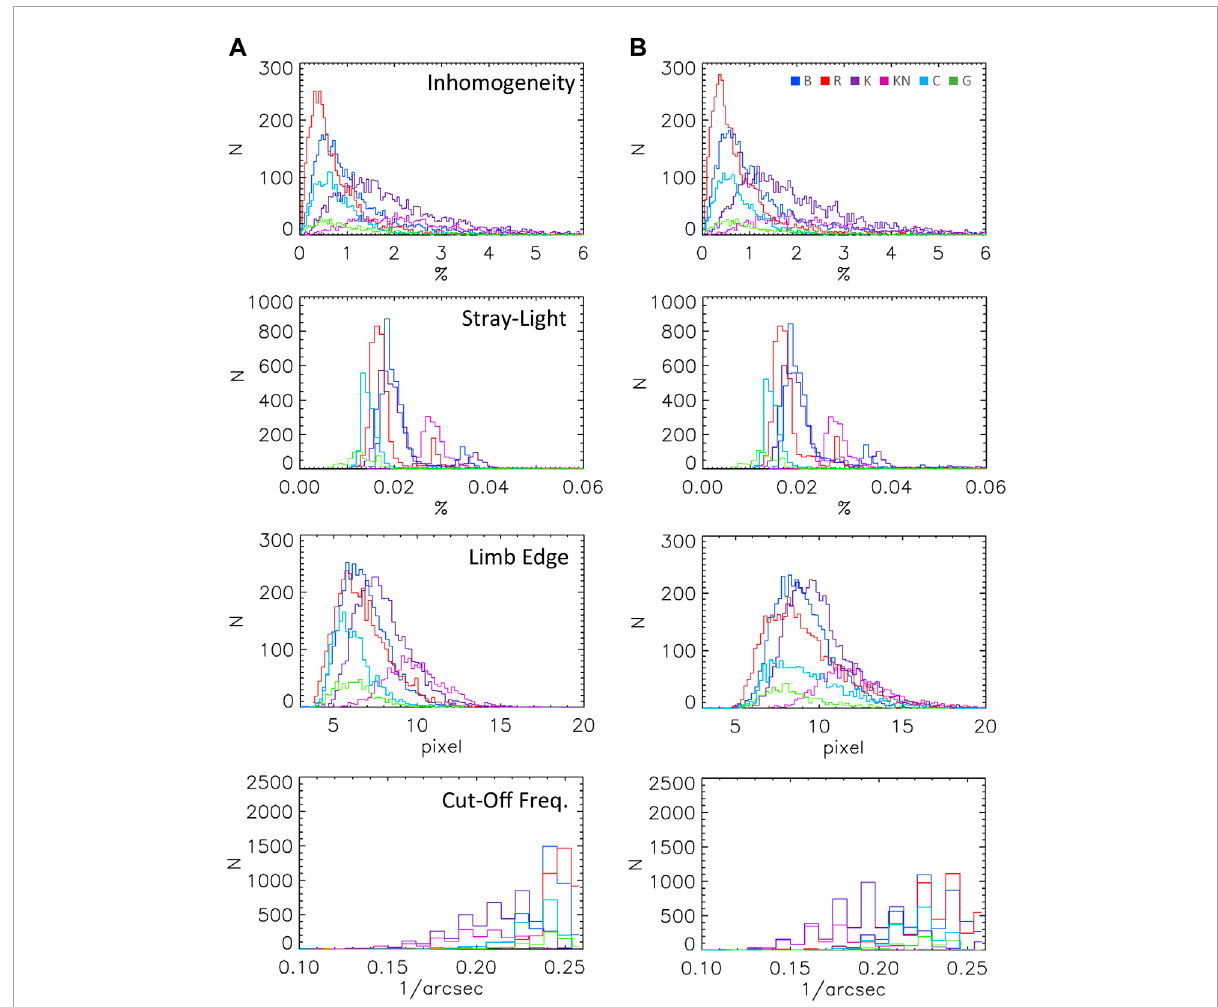
FIGURE 8 Distribution of the values of the parameters measured in each Rome/PSPT image to characterize its quality, for single exposure (A) and sum of 25 exposures (B) observations. From top to bottom each row displays: level of large-scale intensity inhomogeneity at r = 0 . 5 R Sun [%], stray-light level at r = 1.05–1.07 R Sun [%], FWHM of the solar limb edge [arcsec], and cut-off frequency detected [1/arcsec], for observations taken with the diverse filters as specified in the